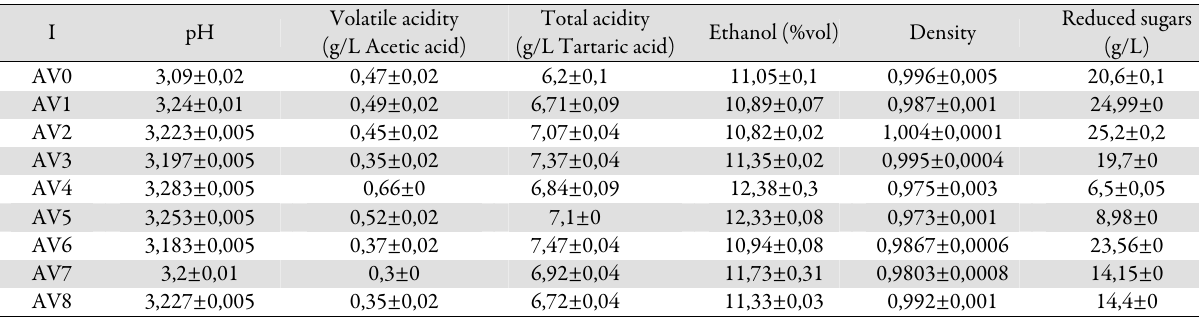
Table 1. Physical-chemical parameters (mean and standard deviation, n=3) of wines made with different yeast